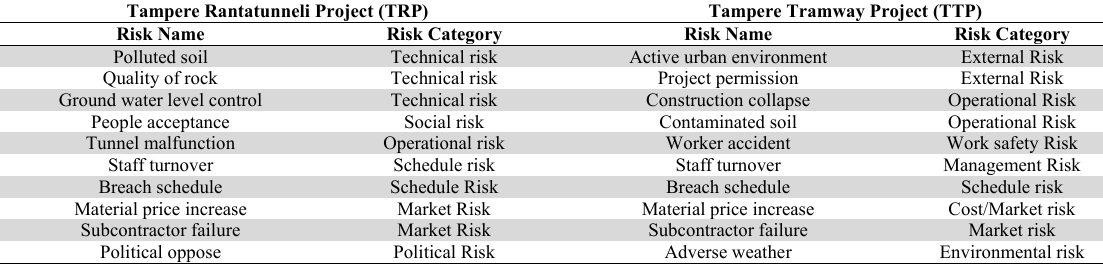
Risk Name and Risk Categories of TRP and